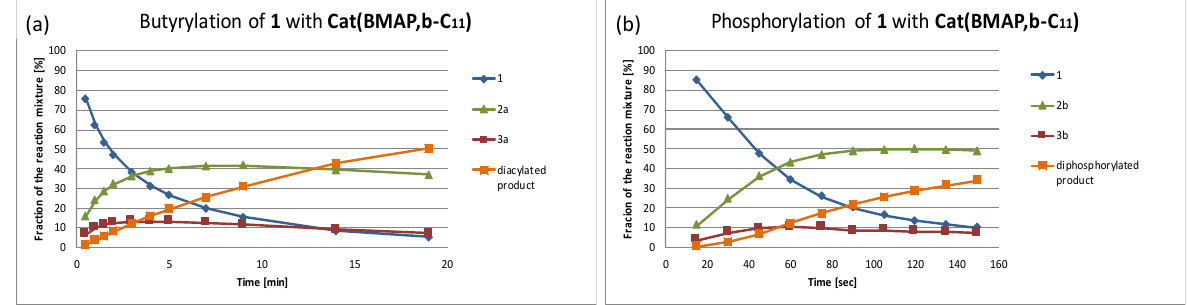
Figure 2. Typical monitoring of the reaction progress: ( a ) butyrylation of 1 ; ( b ) phosphorylation of 1 . Butyrylation reaction conditions: 0.1 mmol of substrate 1 , 0.4 mmol of butyric anhydride, and 0.005 mmol (5 mol%) of Cat(BMAP,b-C 11 ) in 1 mL benzene at room temperature. Phosphorylation reaction conditions: 0.1 mmol of substrate 1 , 0.25 mmol of diphenylphosphoryl chloride, 0.25 mmol DIPEA, and 0.005 mmol (5 mol %) of Cat(BMAP,b-C 11 ) in 1 mL benzene at room